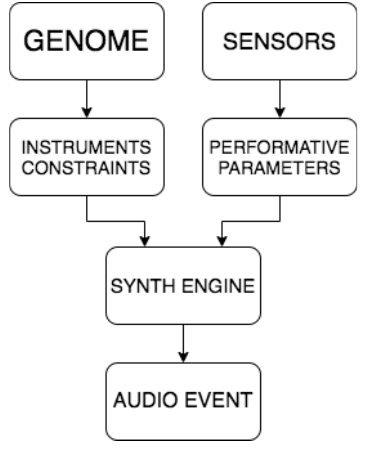
Figure 1. Overview of the whole